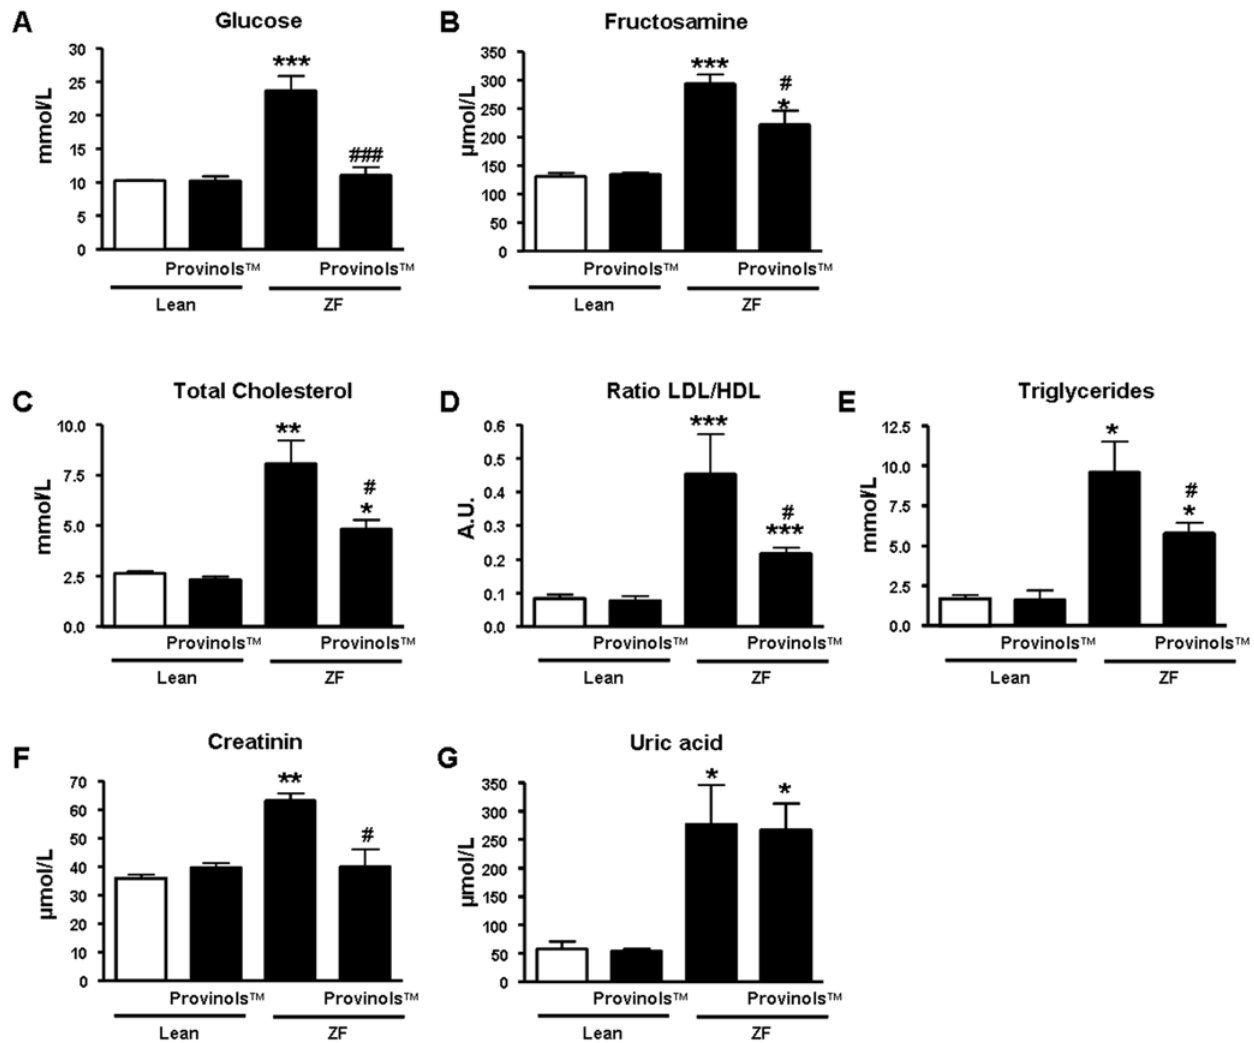
Figure 1. Provinols TM improve metabolic parameters in ZF rats. Circulating levels of glucose (A), fructosamine (B), total cholesterol (C), ratio between LDL- and HDL-cholesterol (D), triglygerides (E), creatinin (F) and uric acid (G) were evaluated in fasting plasma of rats. Values are means 6 SEM ( n =11–12). * P , 0.05, ** P , 0.01, *** P , 0.001 Zucker fatty (ZF) rats vs. lean rats; # P , 0.05, ### P , 0.001 ZF + Provinols TM rats vs. ZF rats.